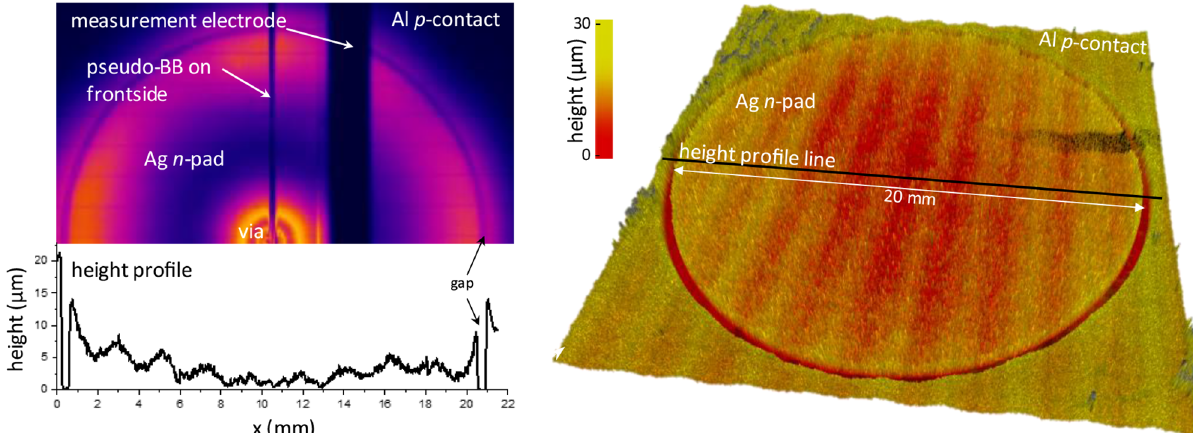
Fig. 7. Pad height in correlation to increased reverse current fl ow illustrated in LIT measurement. The locally increased current fl ow at the n-pad edges (left) in relation to the pad ’ s height pro fi le (below). In addition, a 3D-image of the n -pad showing an increase pad height at the circular edges (right)where reverse currents are high. Note that the frequent linear embossments in the 3D-image are measurement artefacts originating from the stitching of the microscopic images.